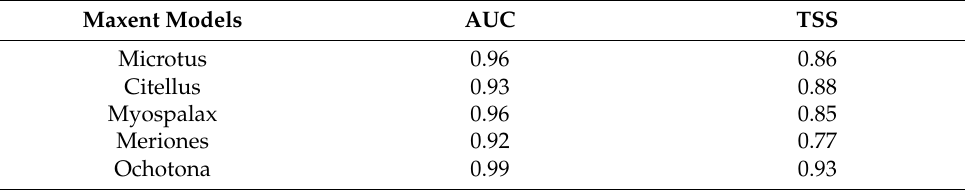
Table 1. The AUC and TSS of all Maxent models for five